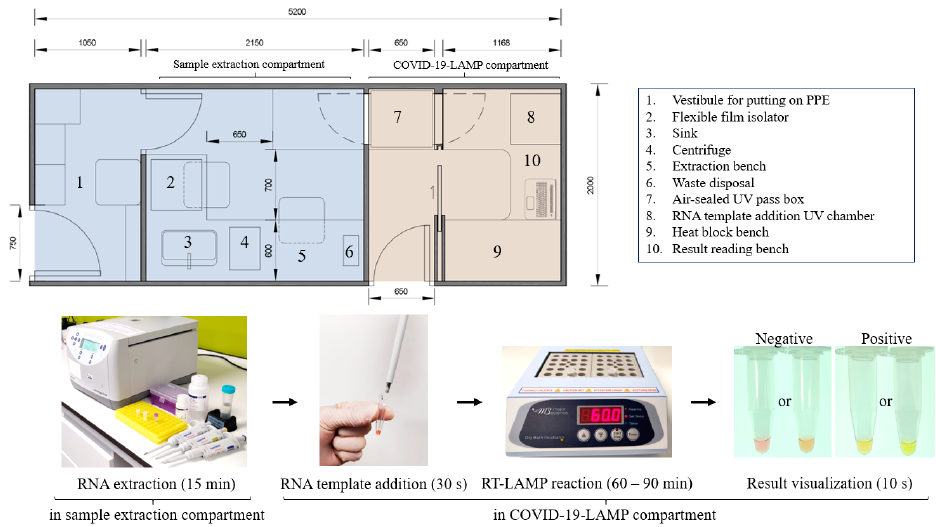
Figure 1. Illustration of a small van-sized mobile COVID-19-LAMP diagnostic unit. A drawn-to-scale layout of a van-sized mobile COVID-19-LAMP diagnostic unit, with sample processing and LAMP reactions compartments have been illustrated. A cargo van / lorry can be modified quickly to become a mobile diagnostic unit for rapid deployment in any